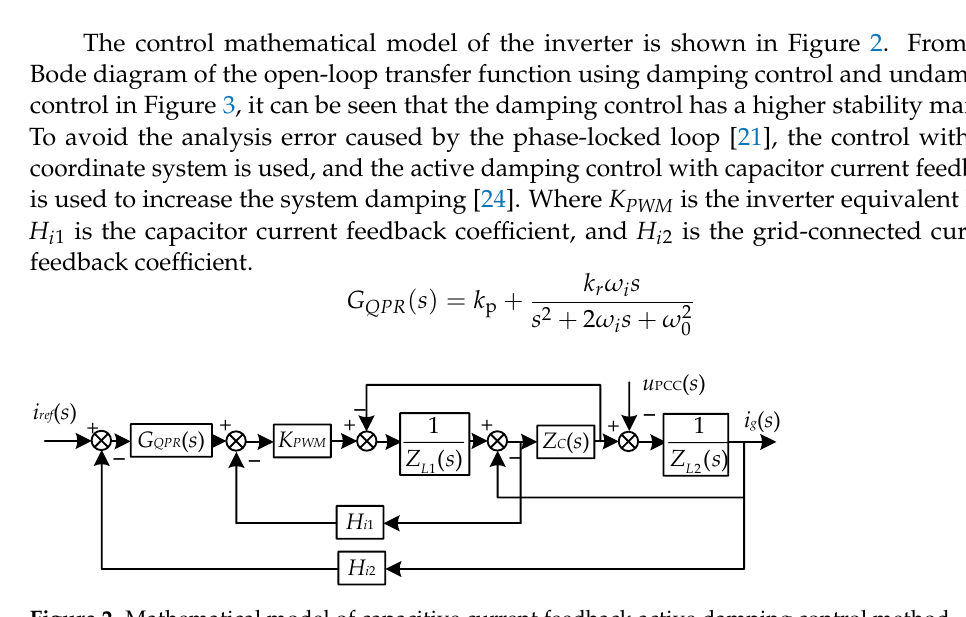
Figure 2. Mathematical model of capacitive current feedback active damping control method.